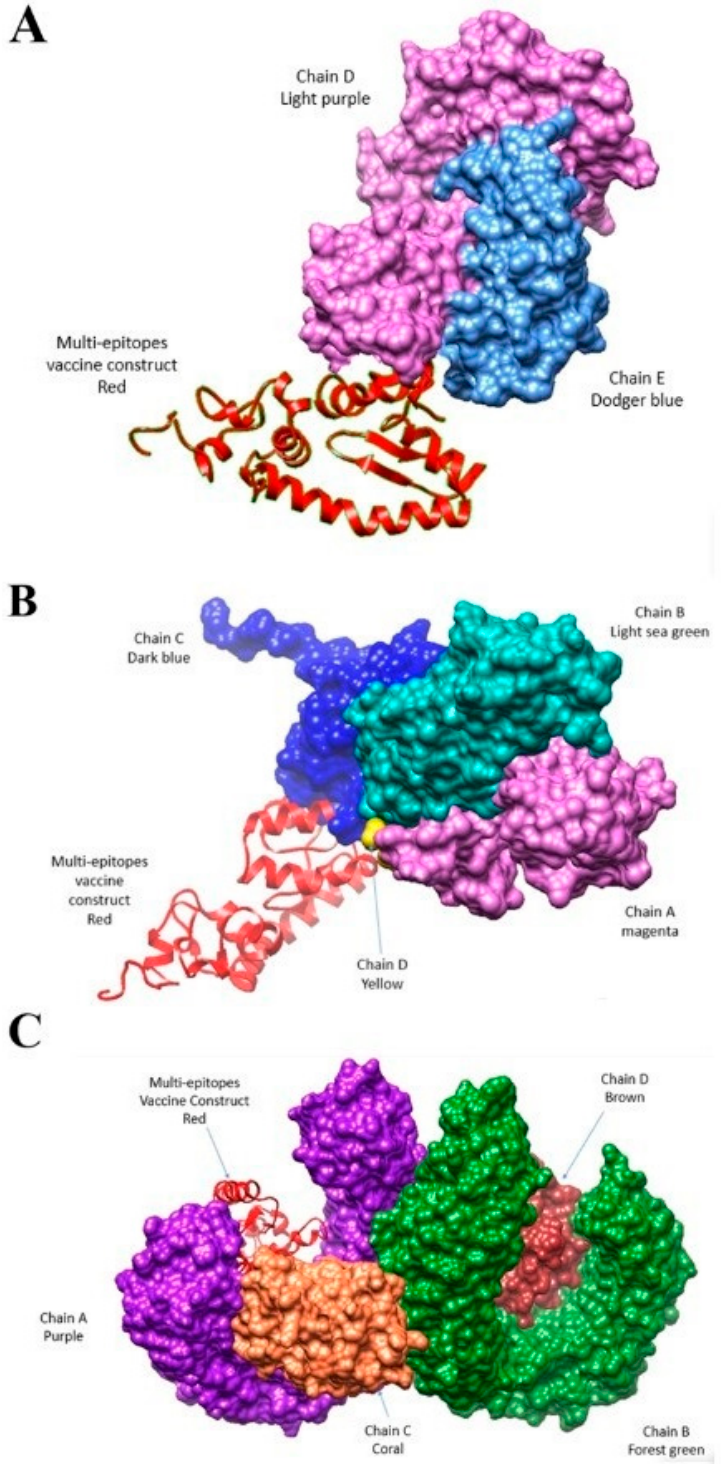
Figure 9. Docked complex of vaccine and MHC-I ( A ), MHC-II ( B ), and TLR-4 ( C ) immune cell receptors.